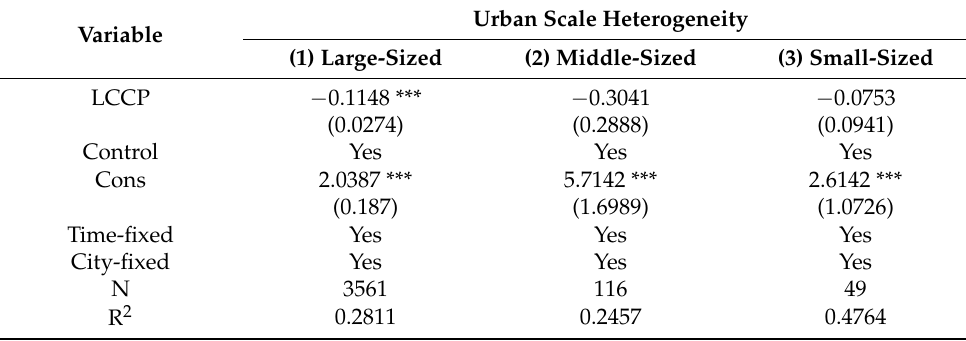
Table 9. Estimation results of analysis of urban scale